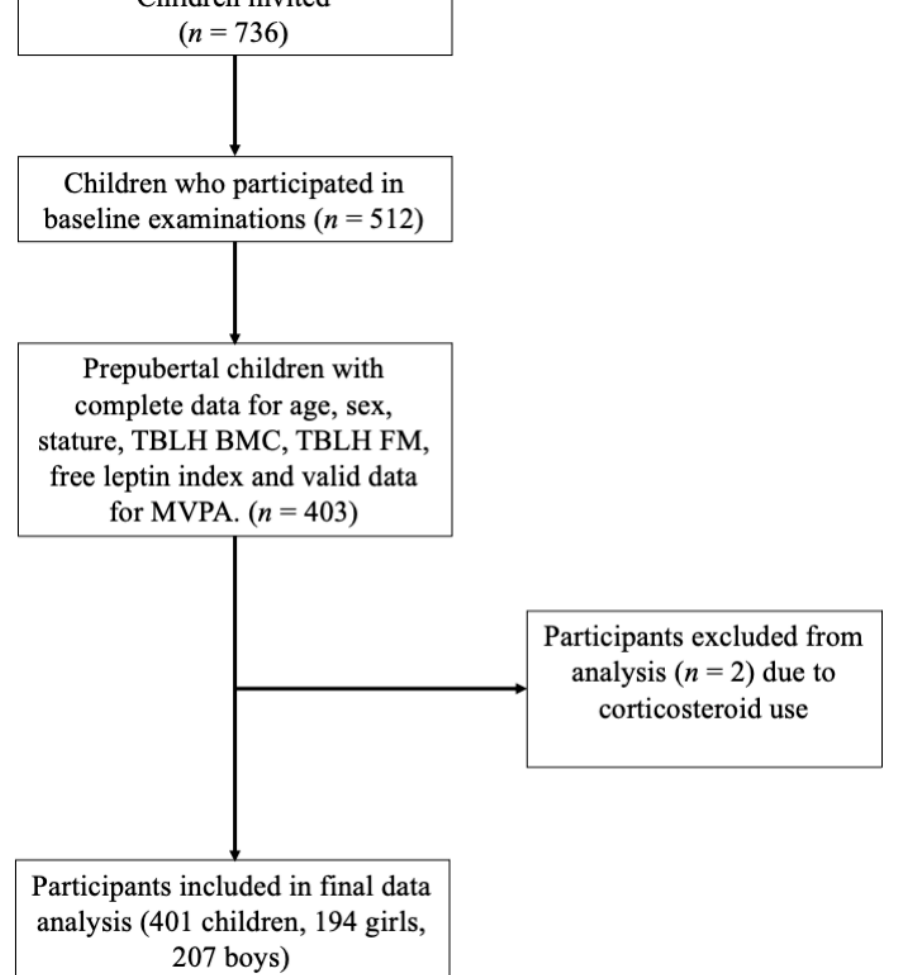
Figure 1. Participant flow chart. Total body less head bone mineral content, TBLH BMC; total body less head fat mass, TBLH FM; moderate-to-vigorous physical activity, MVPA.